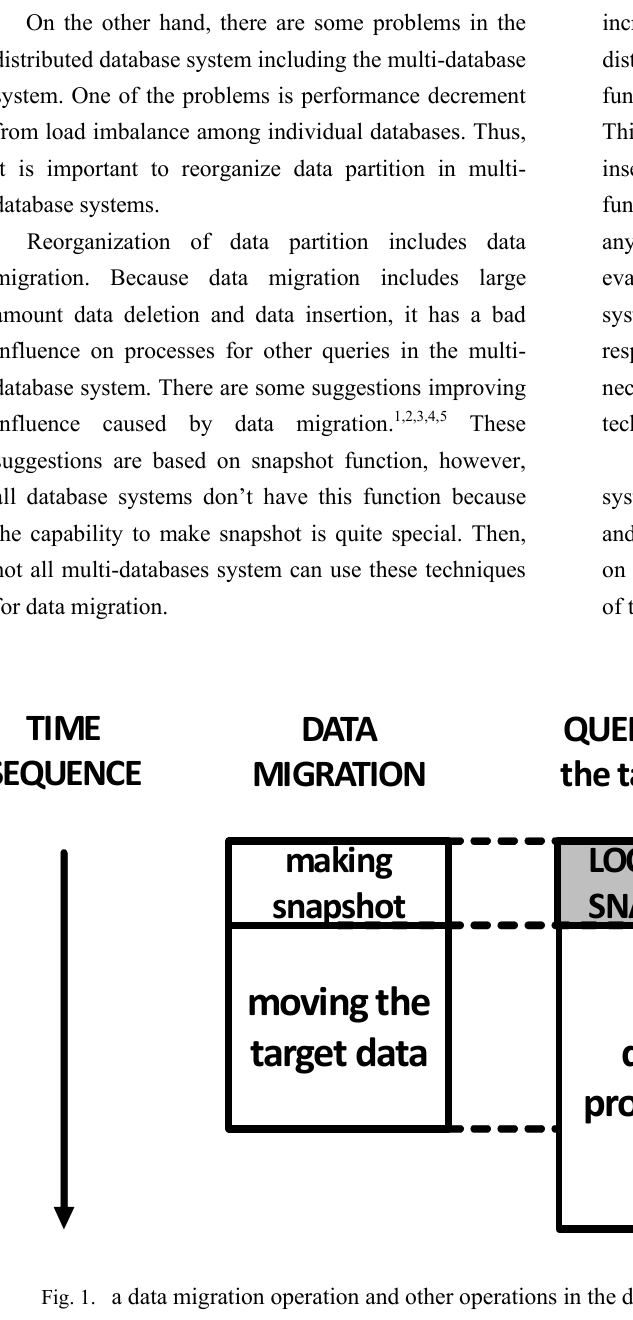
Fig. 1. a data migration operation and other operations in the data migration scheme with making